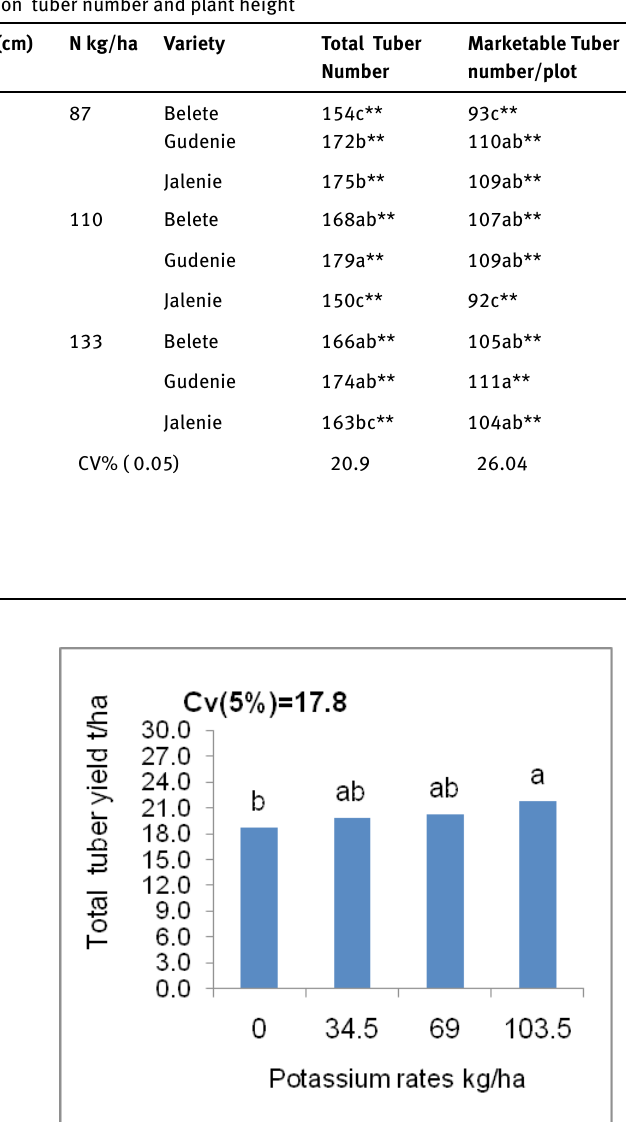
Figure 1: Total tuber numbers for Belete, Gudenie and Jalenie varieties. First and second columns of this figure indicate total tuber number of Belete and Gudenie varieties while the 3 rd shows the Jalenie variety total tuber